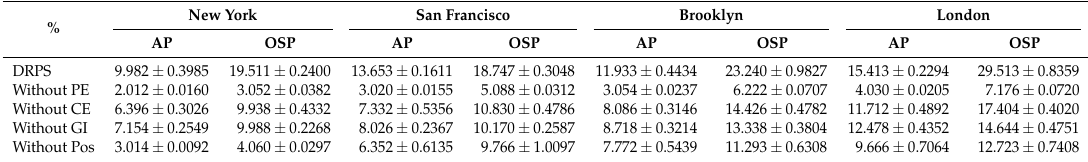
Table 6. Effect of different components on four cities in terms of AP and OSP under the setting where the input and output lengths are, respectively, 30 and 5.